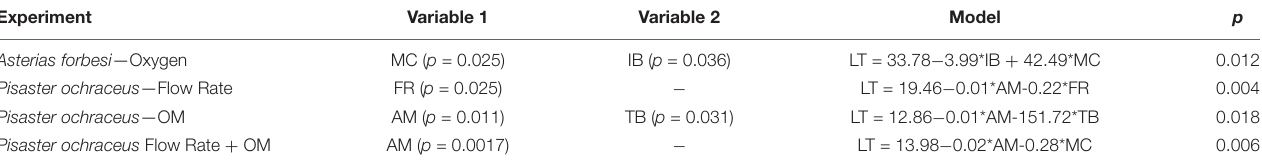
TABLE 1 | Multiple linear regression models of lesion time against measured experimental parameters.